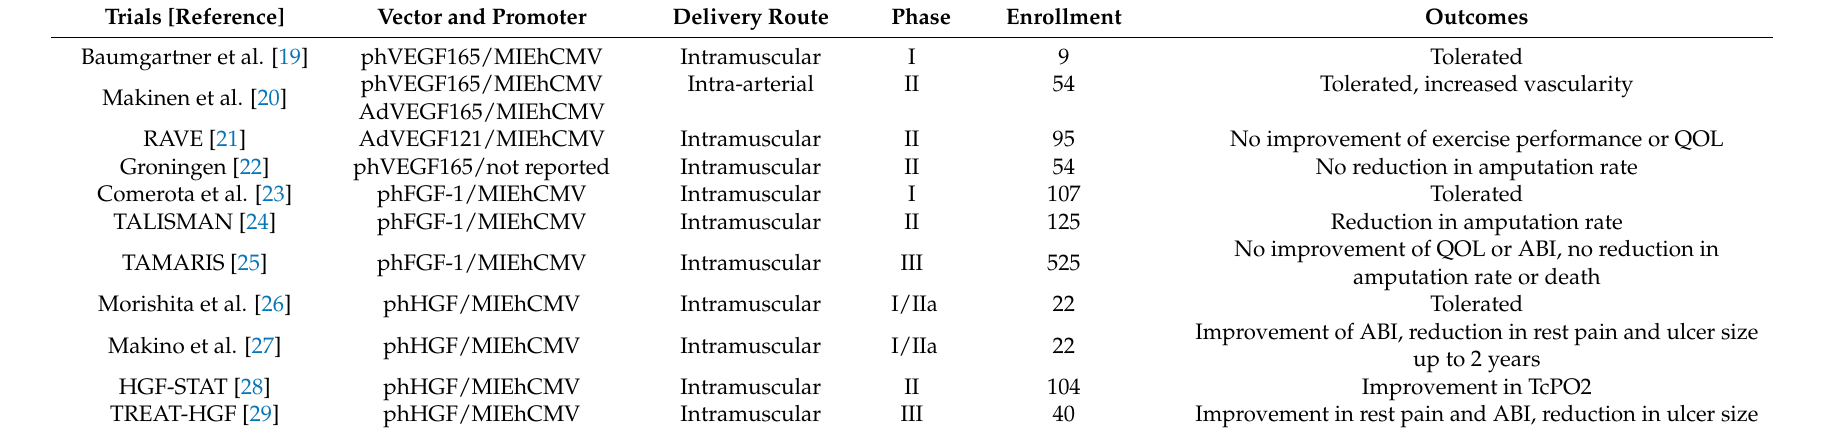
Table 1. Human clinical trials of angiogenic growth factors for patients with peripheral artery disease